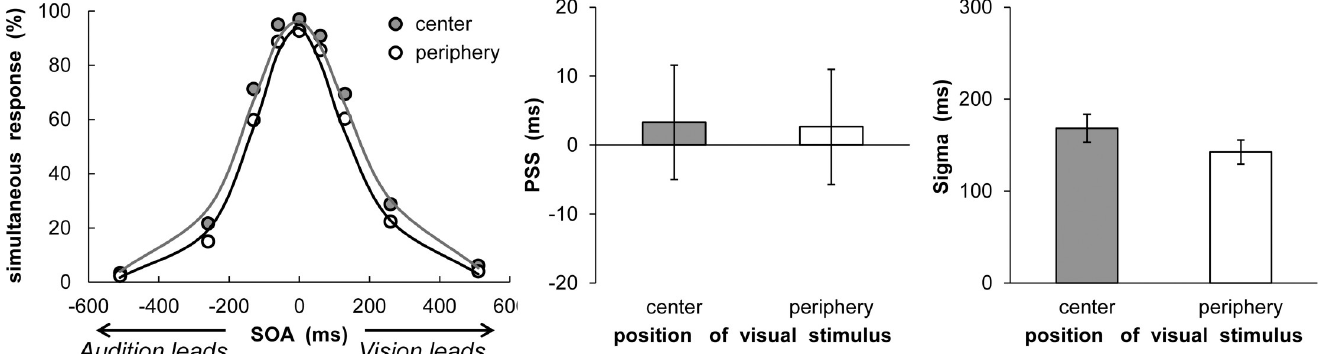
Fig 4. Results of synchrony perception analyses in Experiment 2. (a) Mean percentage of simultaneous responses. The average fitting functions are plotted for the central and peripheral visual field data. (b) Mean estimated point of subjective simultaneity. (c) Mean estimated sigma. Error bars represent standard errors of the mean ( n =